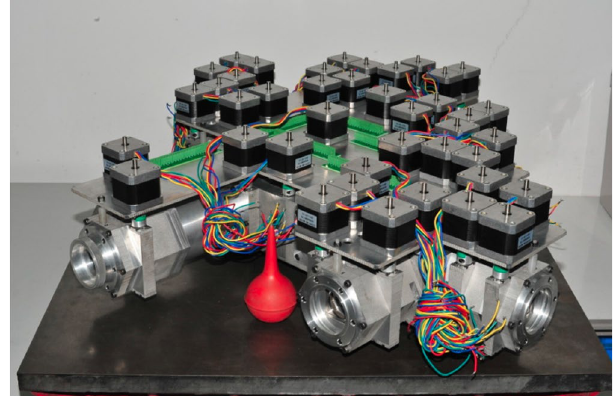
Figure 1. The prototype of Chinese 8-Channel BF filters was proposed by HSOS 17 (photographed by Haiying Zhang). The optical part was designed by HSOS, and the mechanical and electrical parts was built by NIAOT (Nanjing Institute of Astronomical Optics & Technology). The Flat fields, polarization modulation, passband stability, temperature control and satellite data bandwidth for this magnetograph will be the main challenges in the